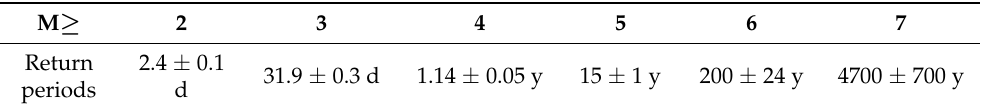
Table 3. Mean return periods of main shocks in function of magnitude M computed in the instru- mental catalogue. These return periods are calculated from G85-GR application (Figure 7). Standard deviations are also reported. d: days; y: